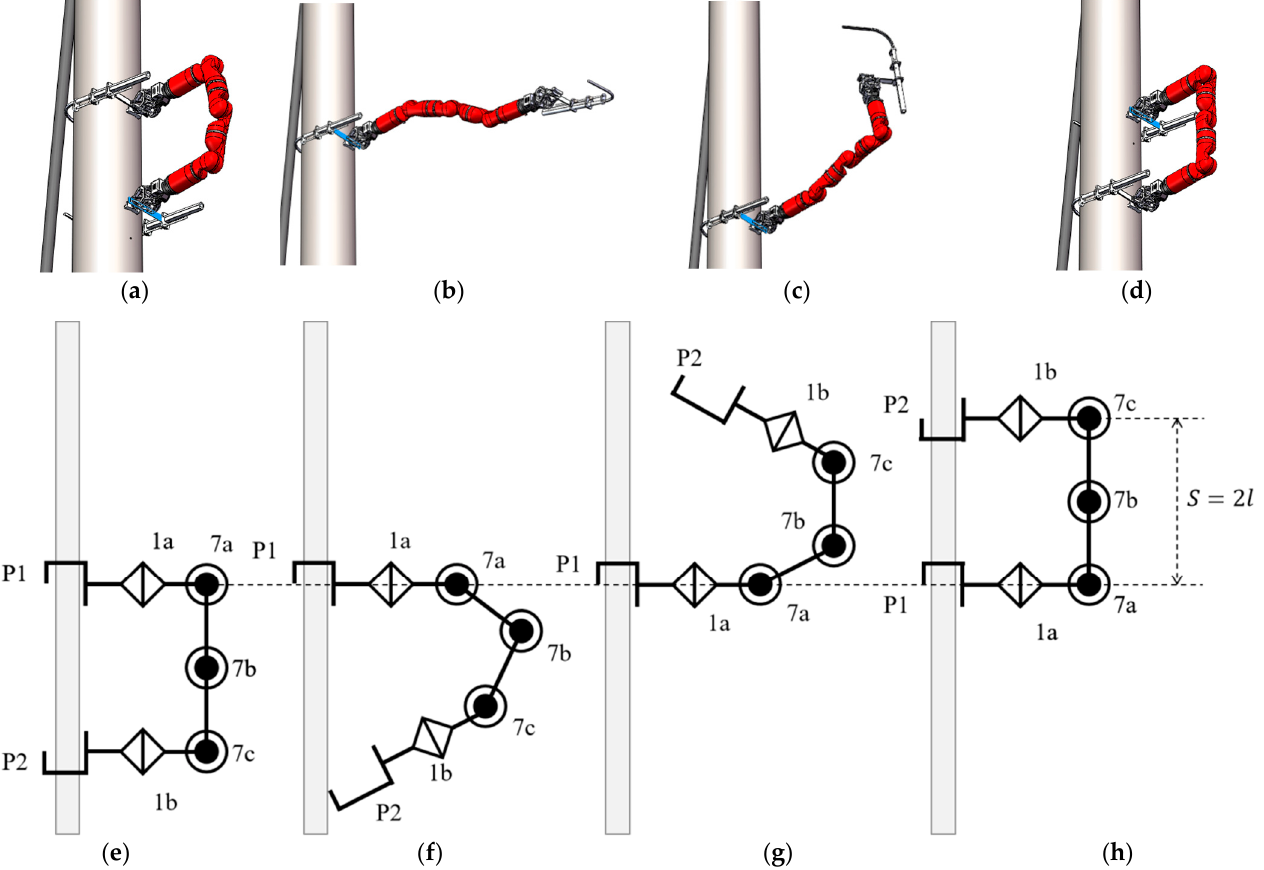
Figure 14. Turning-over gait. ( a ) Initial state, ( b ) motion 1, ( c ) motion 2, ( d ) completed state, ( e ) front elevation of initial motion, ( f ) front elevation of motion 1, ( g ) front elevation of motion 2, ( h ) front elevation of completed state